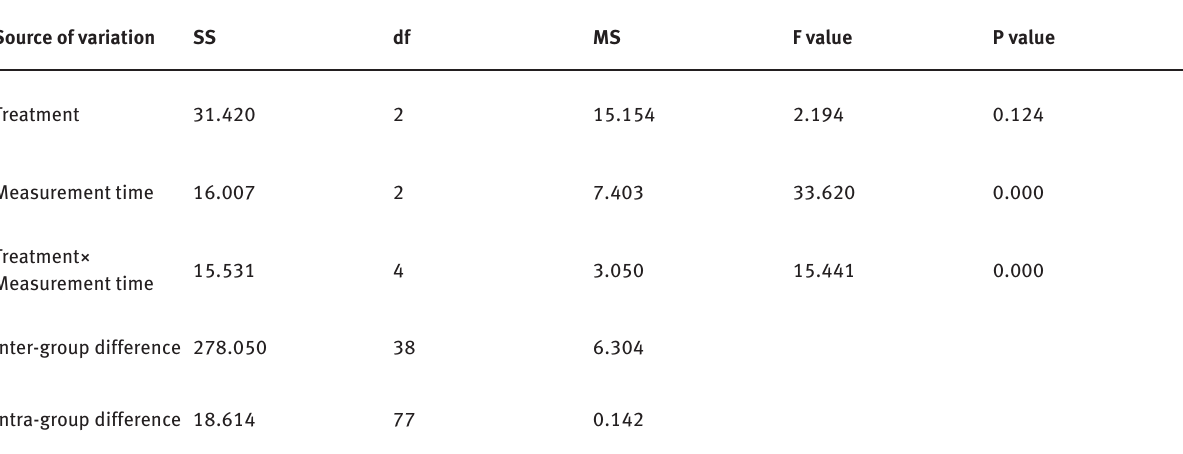
Table 1: Variance analysis of r value of the patients in three groups at different times